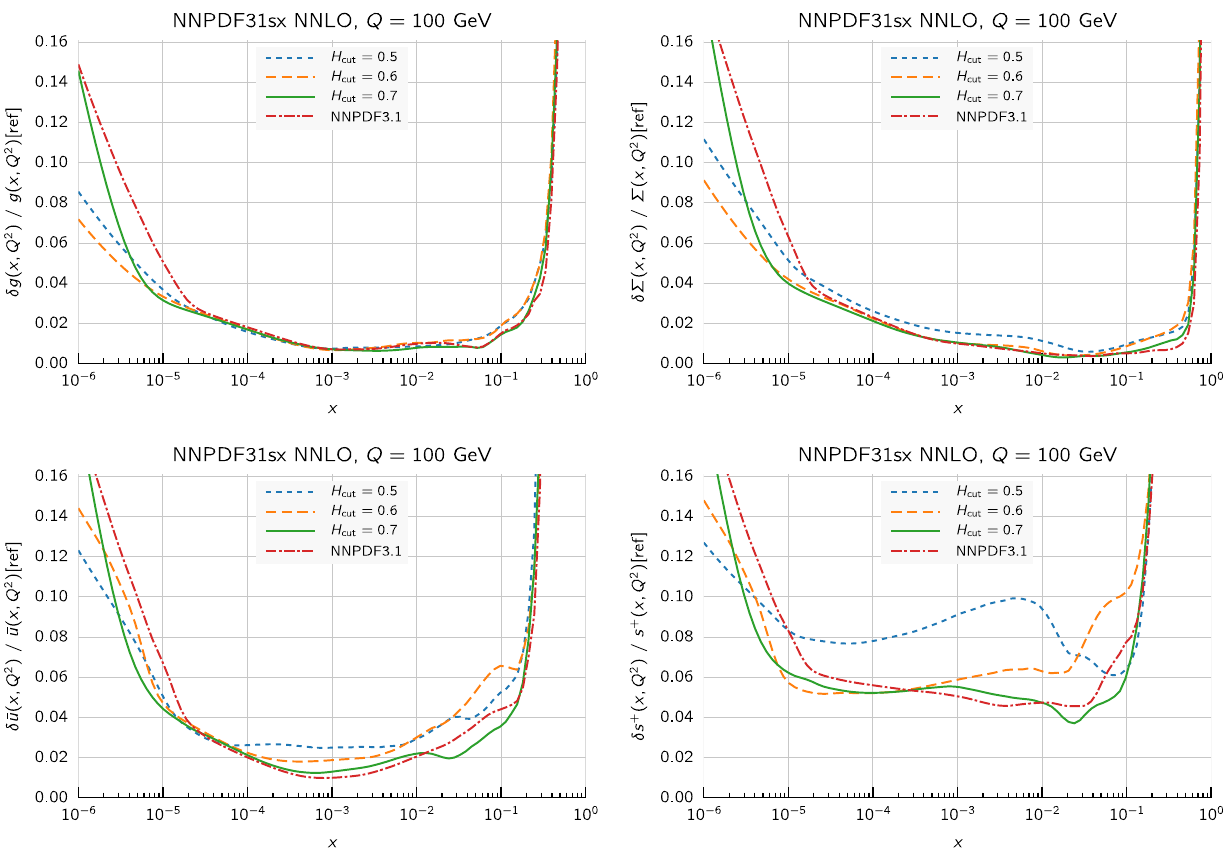
Fig. 18 The relative PDF uncertainties in the NNPDF3.1sx NNLO fits with the three different values of the H cut cut on the hadronic data, compared with those from NNPDF3.1. We show the gluon, the quark singlet, the anti-up quark, and the total strangeness, at Q = 100